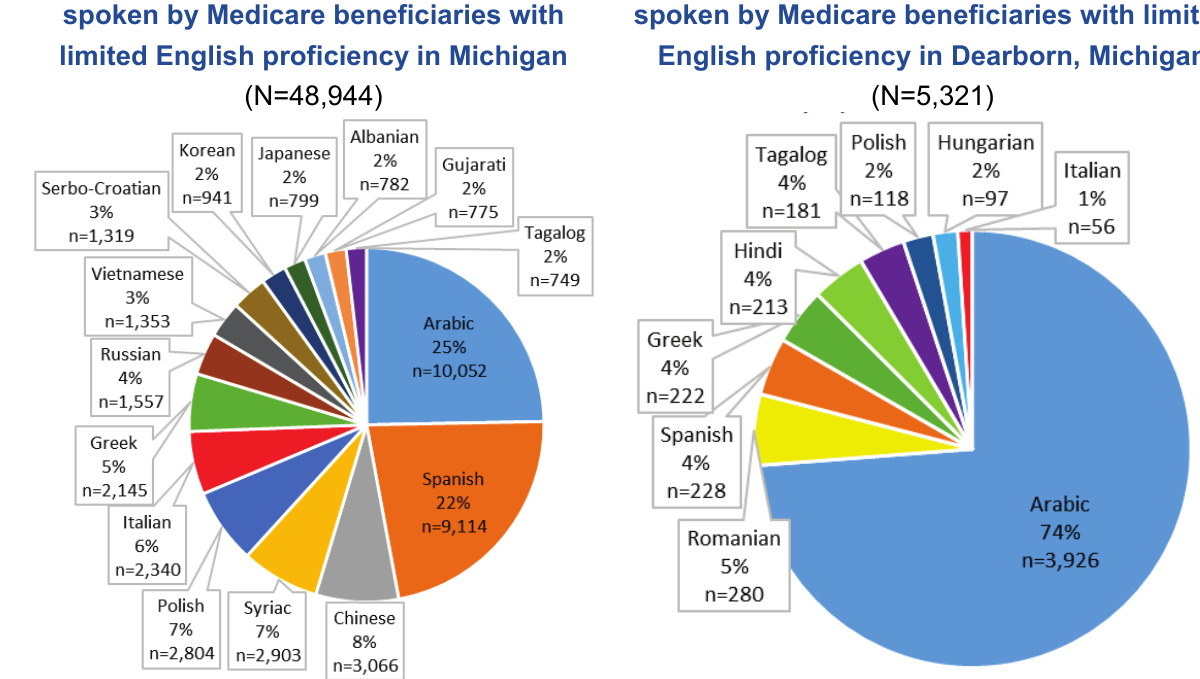
Non-English languages most